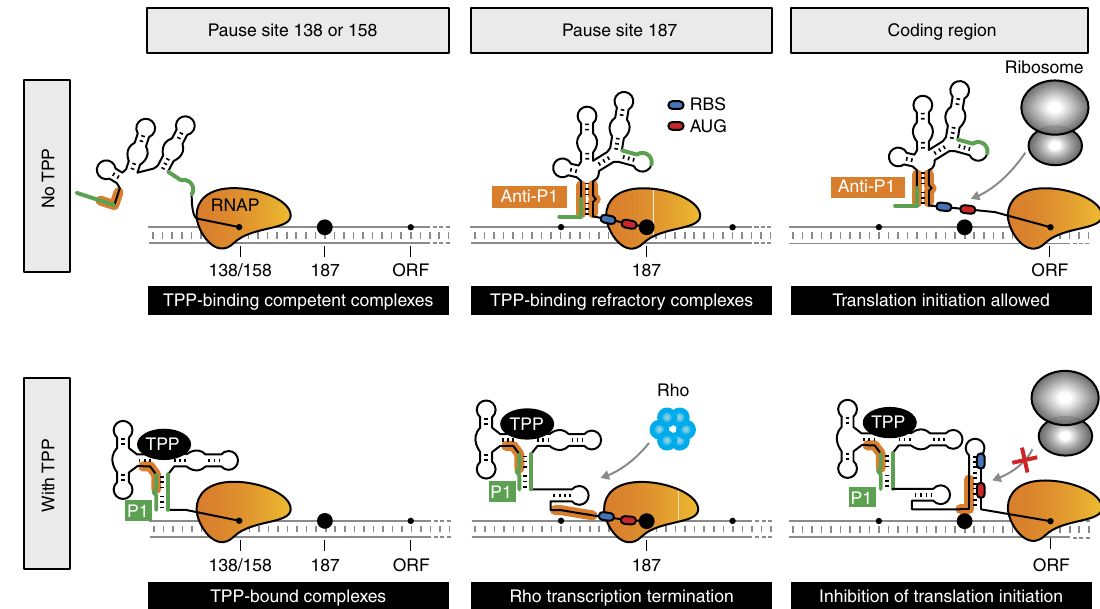
Figure 6 | Transcriptional and translational regulatory mechanisms of the thiC riboswitch. Upper panel: in absence of TPP, transcription elongation complexes located at pause sites 138 or 158 exhibit TPP-binding competent riboswitch structures. However, elongation complexes reaching pause site 187 adopt the anti-P1 structure that strongly reduces TPP-binding affinity. Elongation complexes reaching the coding region allow efficient 30S ribosomal subunit binding and translation initiation. Lower panel: in presence of TPP, elongation complexes located at pause sites 138 or 158 exhibit thiC riboswitch structures, in which the P1 stem is formed. On reaching the 187 pause site, a significant fraction of elongation complexes undergo Rho transcription termination. However, elongation complexes carrying on transcription into the coding region allow the formation of the sequestering stem, inhibiting translation